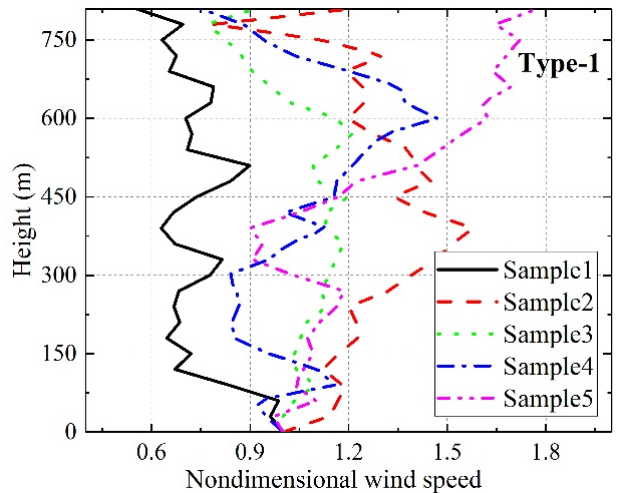
Figure 10. Wind speed profile of Type-1.